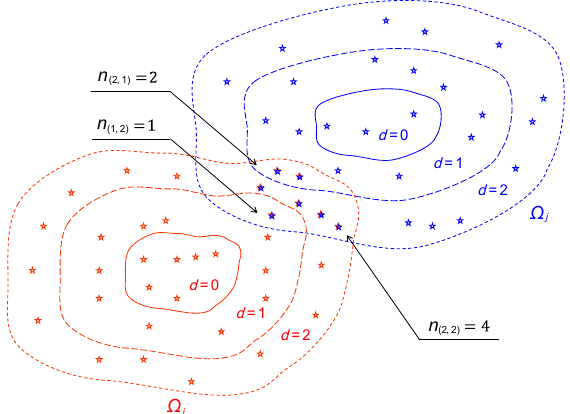
Fig. 6 Intersection between two clouds with several